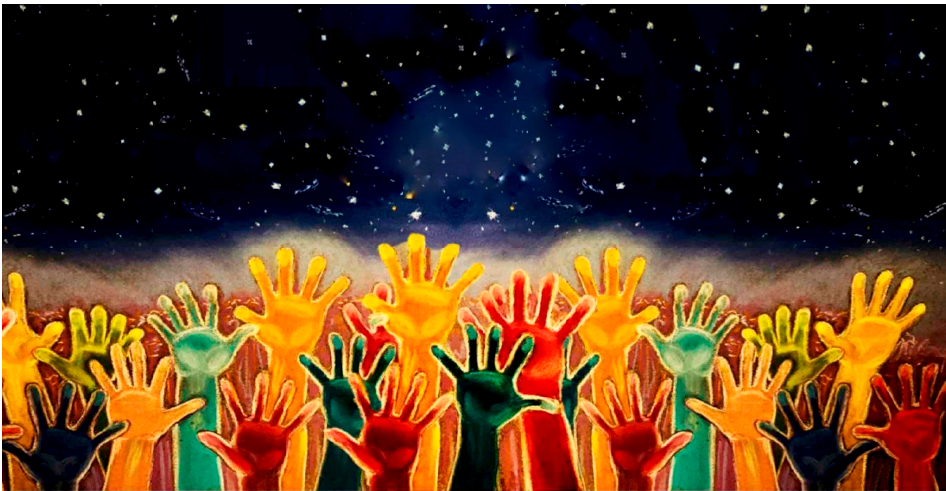
Figure 1. High-level wellness is applicable to organizations, communities, nations, and humankind as a whole. In an era of gross environmental concerns and a crisis of non-communicable diseases, personalized medicine must be increasingly viewed in the context of planetary health [image by author, S.L.P.].